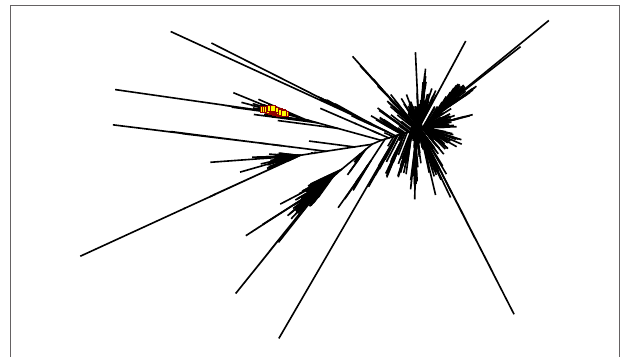
FigUre 6 | Phylogram generated from productive reads of one of the DNP-immunized animals. The peptide ASGYTFTSYYIGWIK was abundantly found in affinity-enriched immunoglobulins in the proteomics data. NGS reads that contain peptide motif were highlighted in red in the phylogram, and show a set of DNP-specific reads in relation to the overall repertoire. Figures for the other animals in this group are in Figure S7 in Supplementary Material.